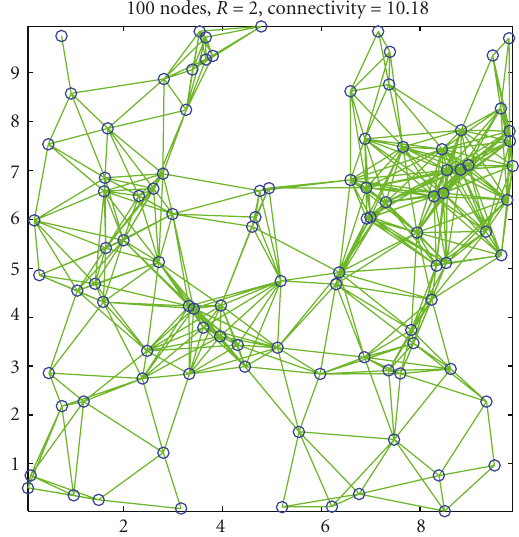
Figure 9: An actual random deployment